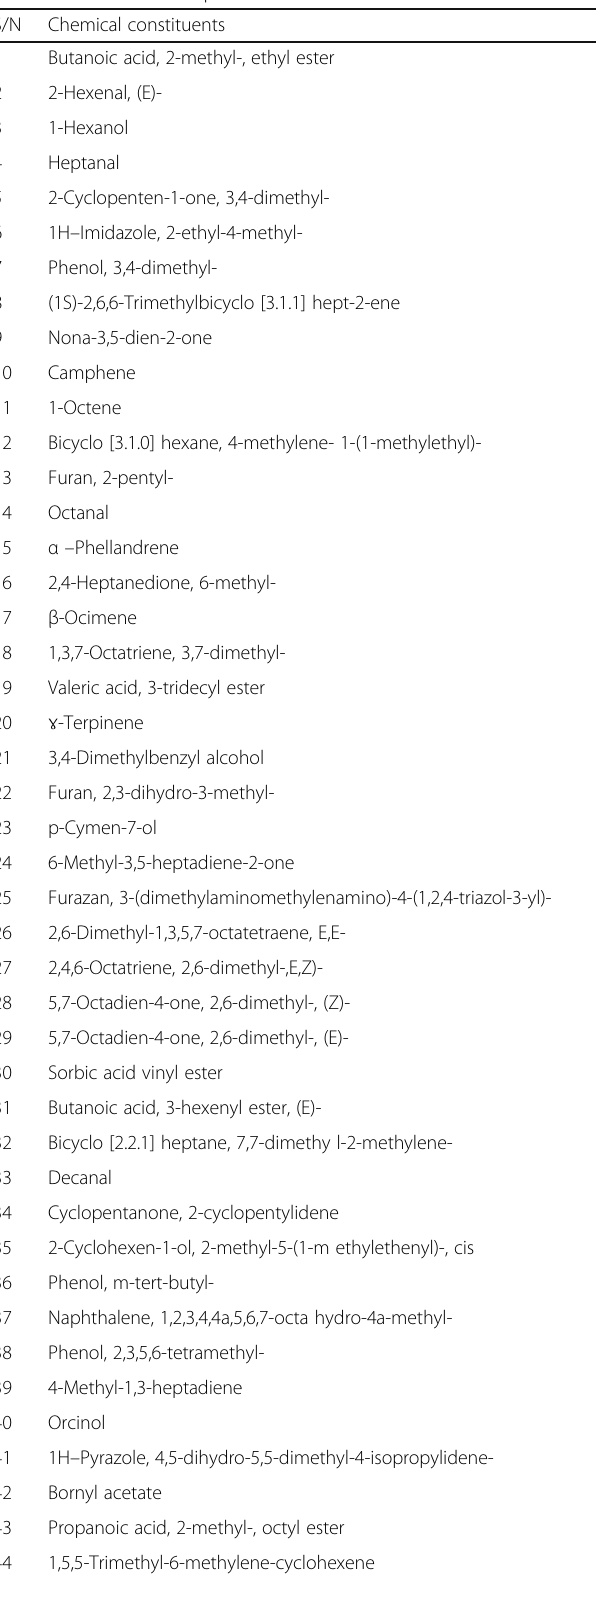
Table 2 Chemical composition of the essential oils of T. minuta flower